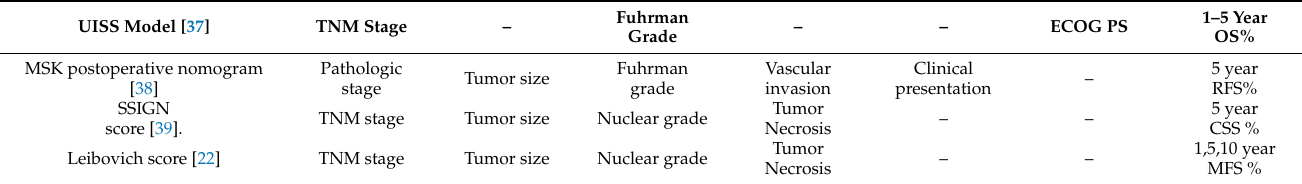
Table 3. RCC Risk Models for Patient Selection after cytoreductive